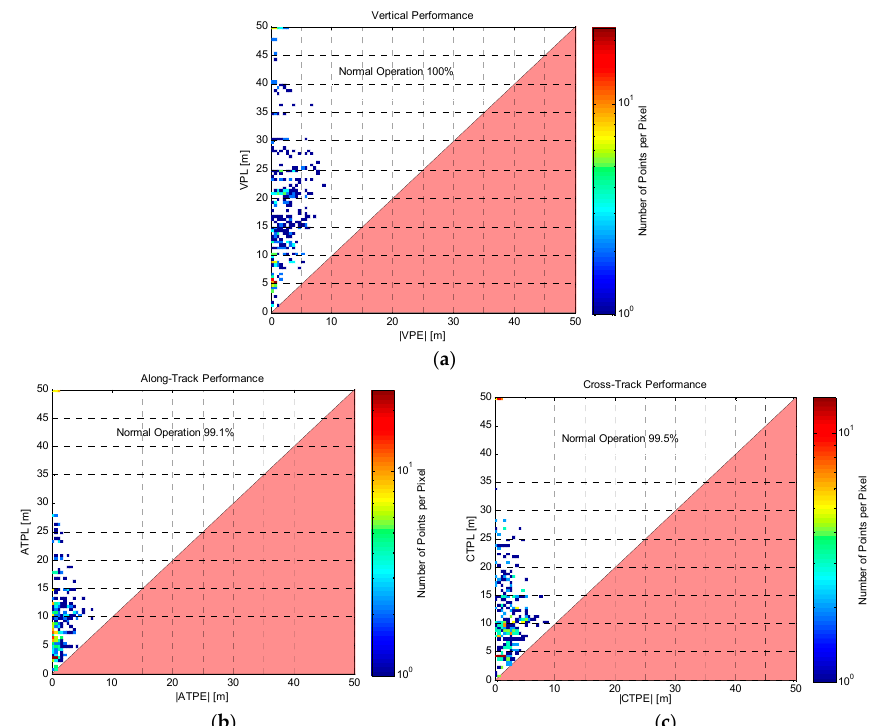
Figure 7. Assessment of the conservativeness of LPL values in terms of Stanford plots: ( a ) Vertical direction; ( b ) Along-Track direction; ( c ) Cross-Track direction.